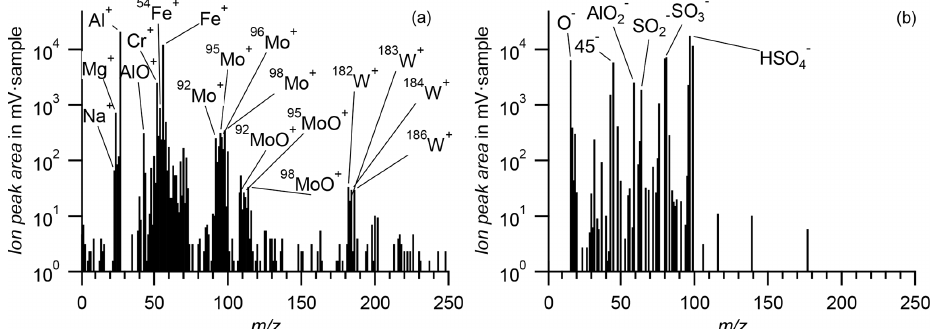
Figure 13. Exemplary single-particle stick spectrum recorded during StratoClim 2017 demonstrates the feasibility of identifying metallic isotopes. (a) Cations; (b) anions. This particle containing heavy metal and sulfate was measured at an altitude of 20402m (29 July 2017, 06:09:34UTC, d va = 602nm).